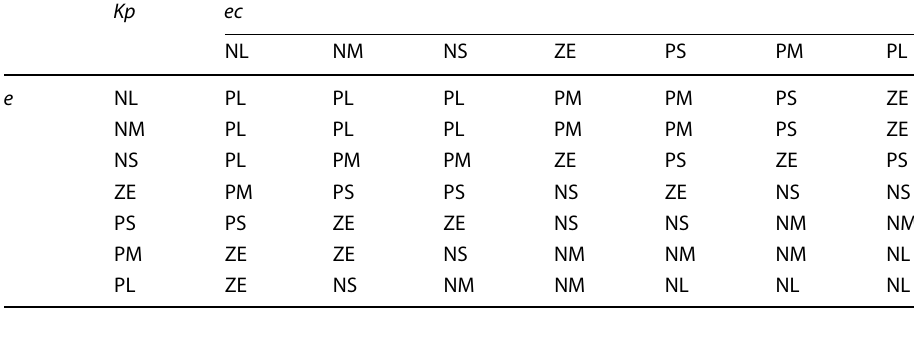
Table 2 Fuzzy rule list for Ki and e ,